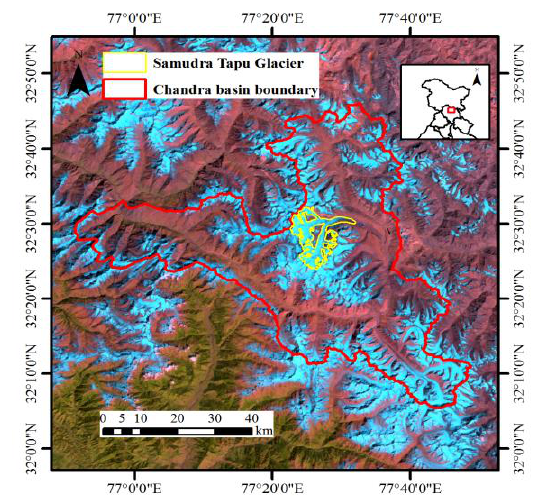
Figure 1. Location Map of Samudra Tapu Glacier in Chandra basin Sensor & Resolution